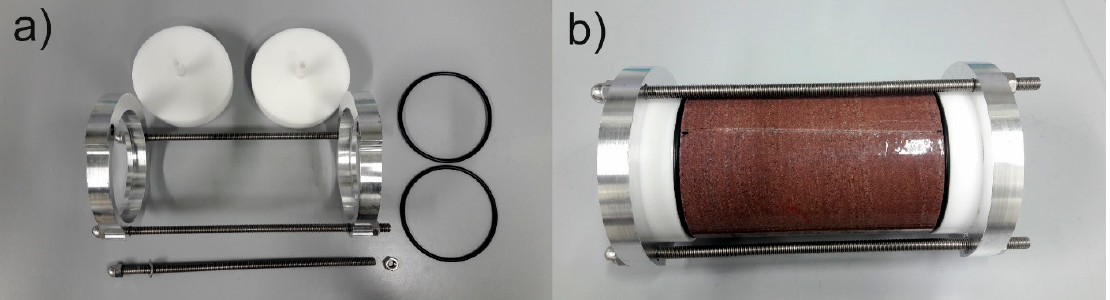
Figure 3 . ( a ) Accessories for the clamping device of the specimen: Teflon attachments, aluminum clamping rings, clamping screws and sealing rings. ( b ) Prepared sandstone specimen in shrinking tube and clamped in the equipment.